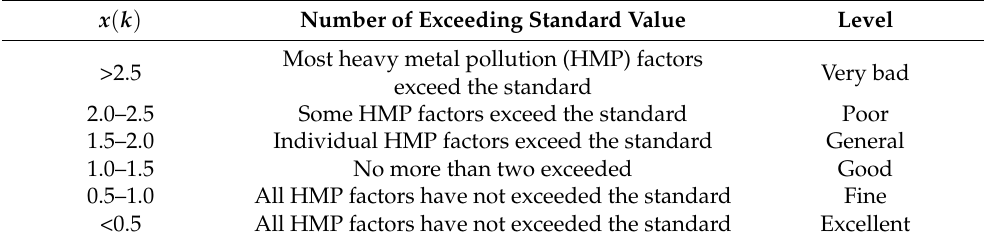
Table 1. Classification table of soil pollution degree of heavy metals.